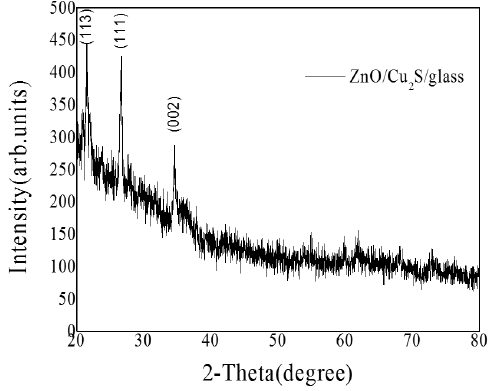
Figure 19. The XRD patterns of ZnO/Cu 2 S/glass films.